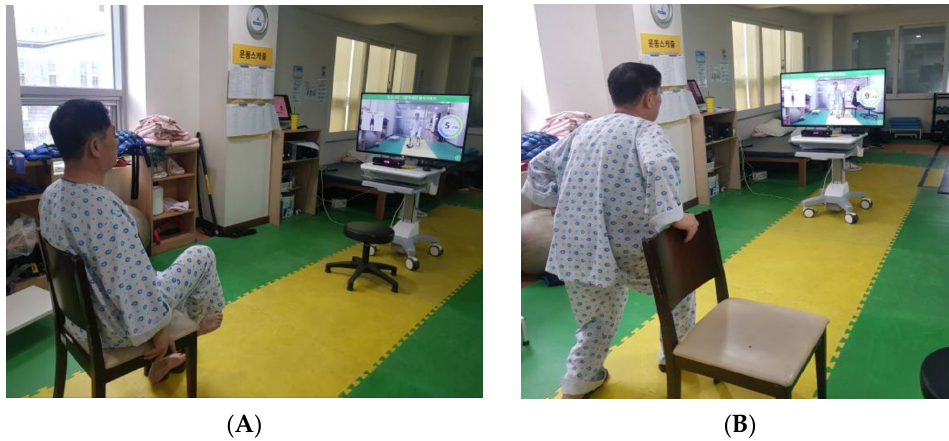
Figure 2. AR ‐ based training session. ( A ) The second ‐ week training session in sitting position. ( B ) The third ‐ and fourth ‐ week training session in the standing position. ( B ) The third- and fourth-week training session in the standing